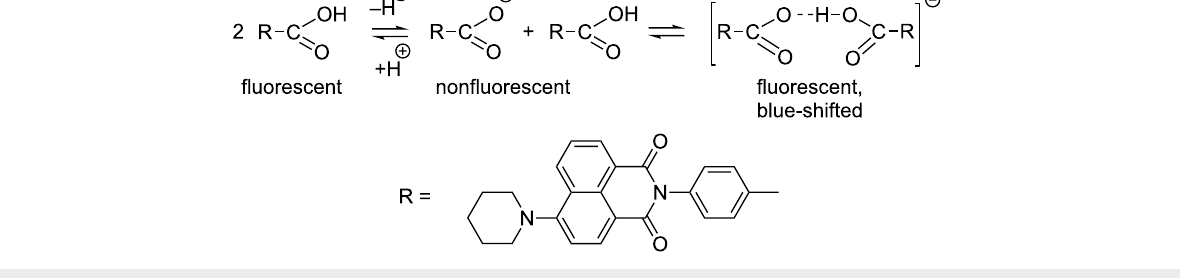
Scheme 2: Possible ionization and complexation of 4 in ethanol.